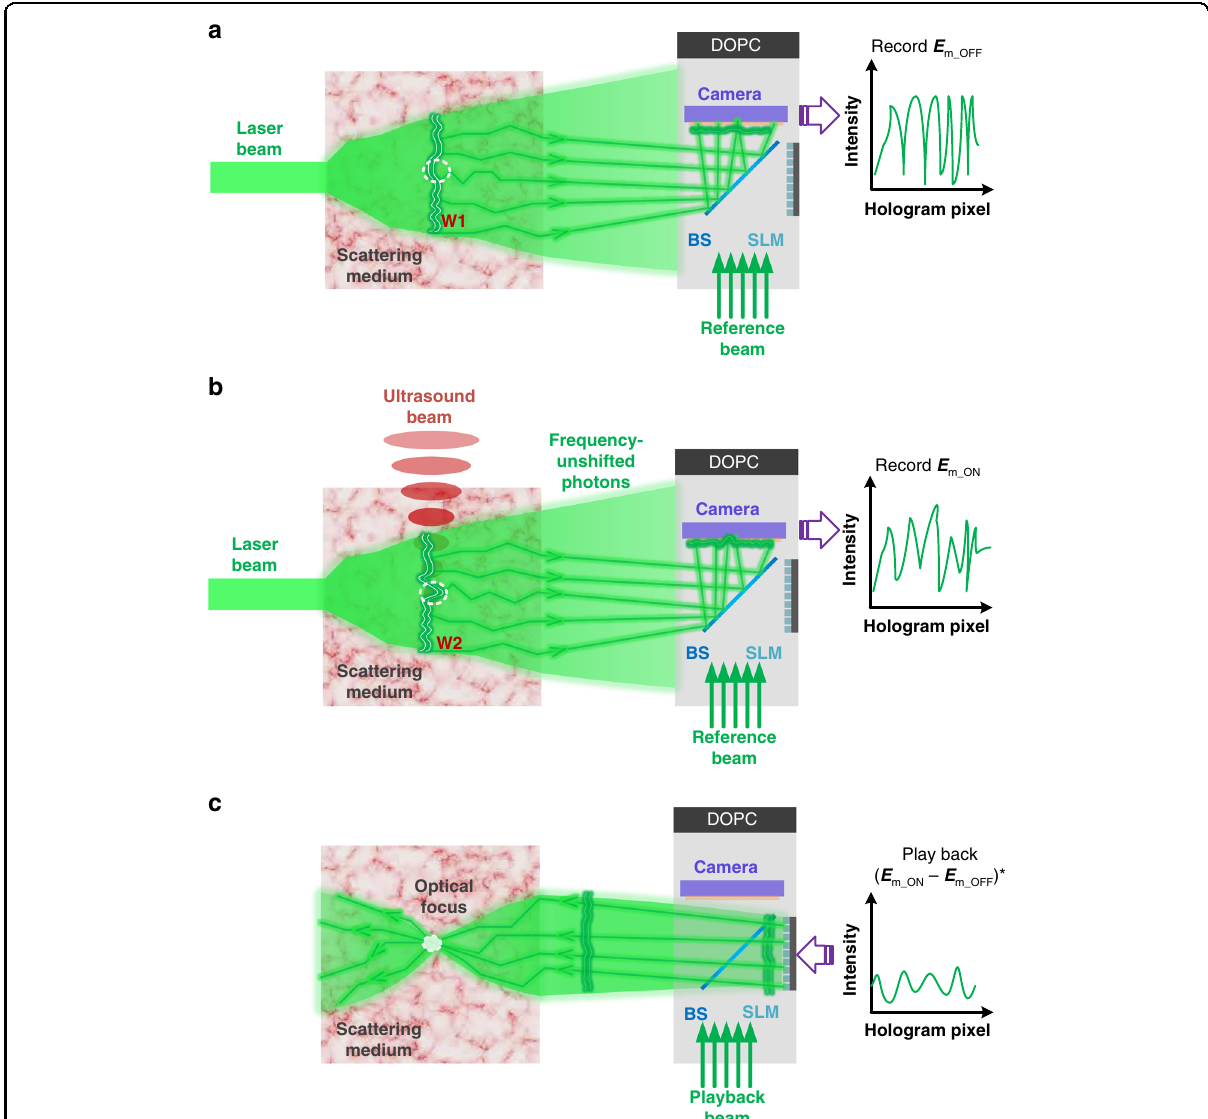
Fig. 1 Principle of UFP optical focusing. In UFP optical focusing, we detect only the frequency-unshifted scattered photons because their higher energy dominates over that of the extremely weak frequency-shifted photons by an ultrasound fi eld. a The scattered fi eld through the scattering medium is directly measured via interference with a reference beam while the ultrasound is OFF. b Repeat the same measurement as in a while the ultrasound is ON. c The signals measured in a and b are different because of the ultrasound-induced fi eld perturbation. Playing back the phase- conjugated differential fi eld via a DOPC system generates a time-reversed beam that converges to the location where the perturbation